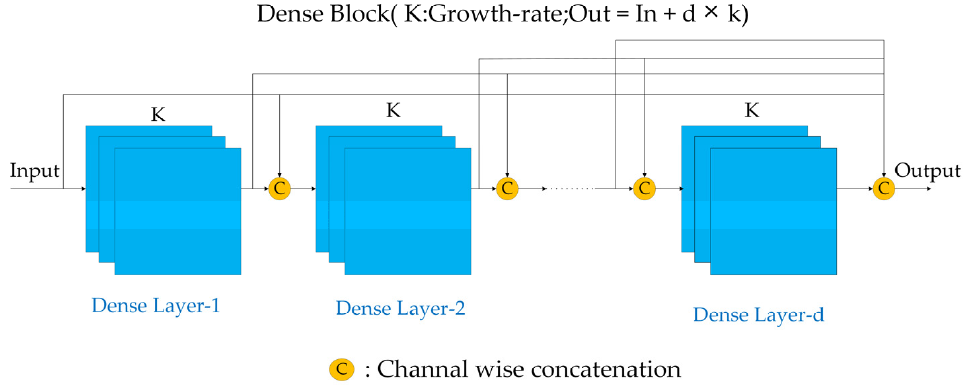
Figure 2. Structure of dense block.